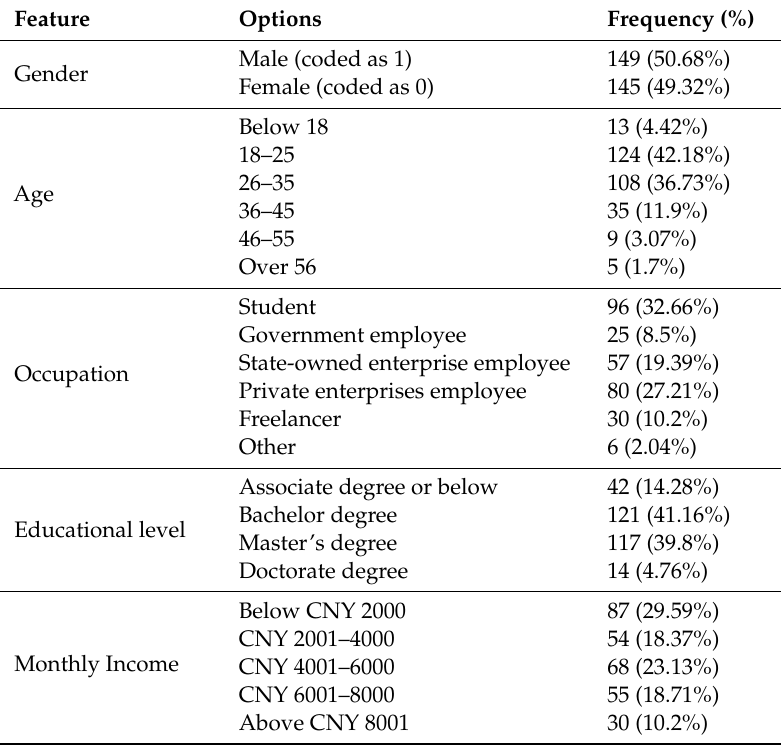
Table 1. Participant Profile ( n =